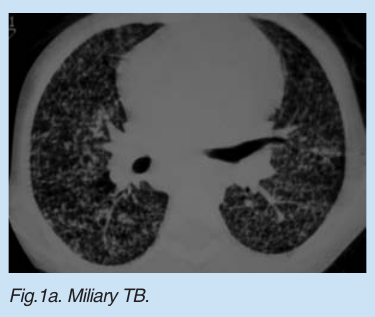
Fig.1a. Miliary TB.